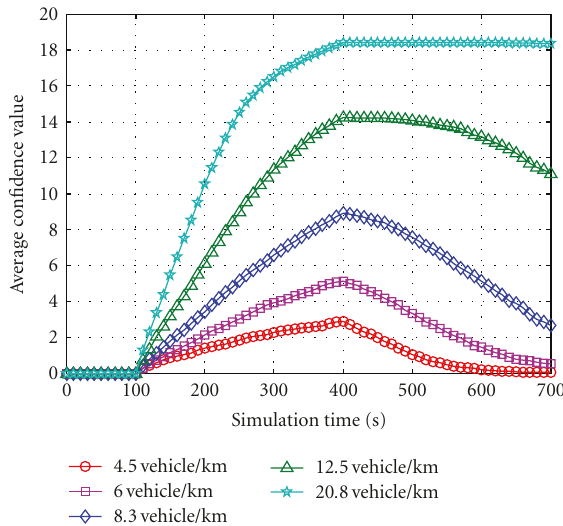
Figure 7: Average accumulation speed of event confidence value to vehicles under di ff erent tra ffi c